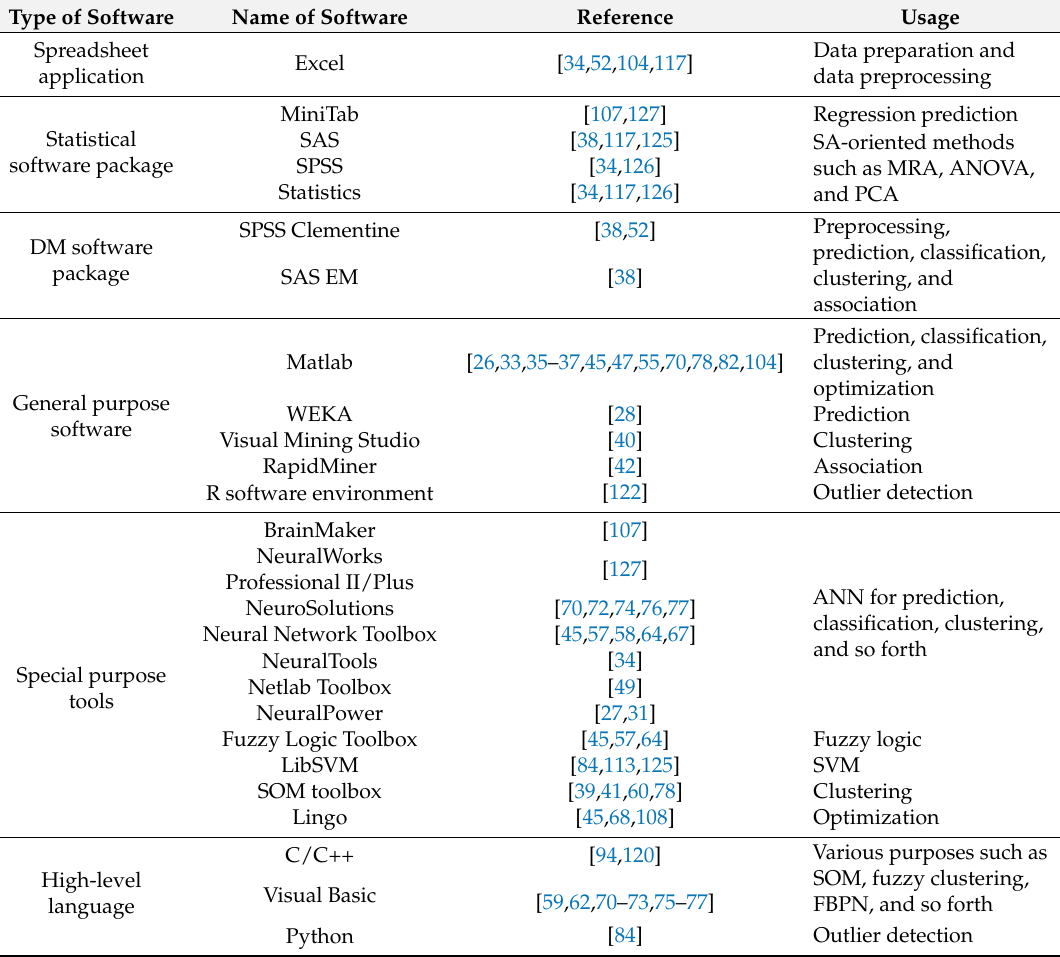
Table 14. The software used for accomplishing DM and Big Data application in the electronics